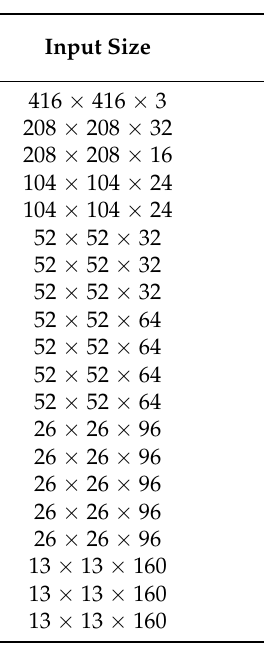
Table 1. Adopted MobileNetv2